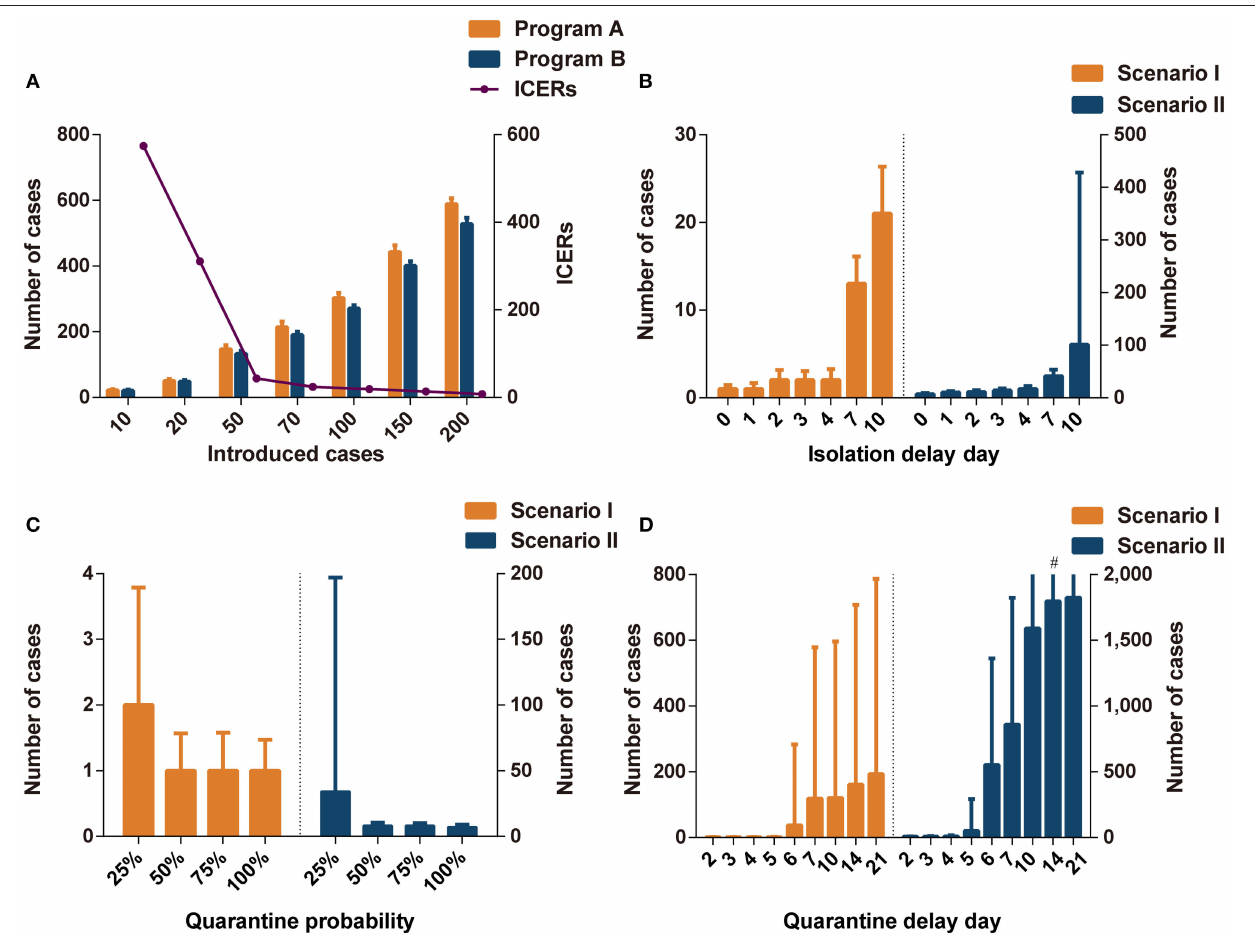
FIGURE 1 | The impact of different parameters on interventions effectiveness. (A) The comparisons of infections in programs A and B in different introduced cases. (B) The impact of isolation delay day in program A in different scenarios. (C) The impact of quarantine probability in program A in different scenarios. (D) The impact of quarantine delay day in program A in different scenarios. Program A: personal protection and isolation-and-quarantine; Program B: personal protection and community containment. ICERs: incremental cost-effectiveness ratios (US$1,000 per case avoided). # The interval extends out of the plotting